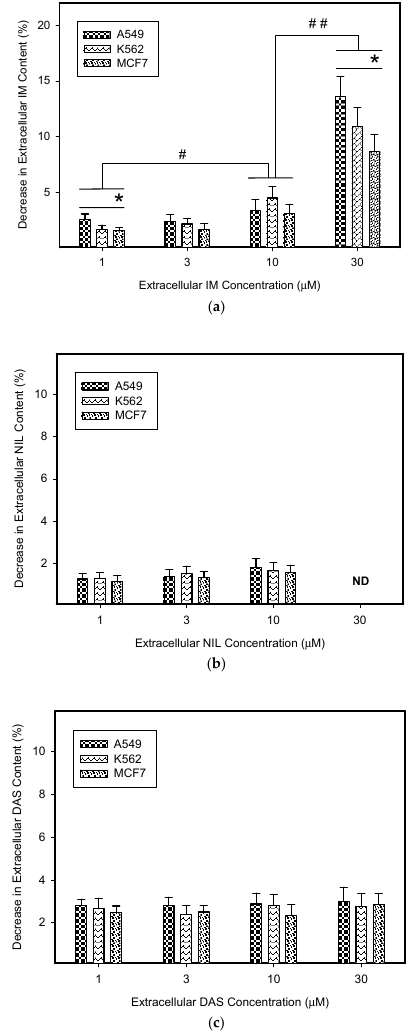
Figure8. LysosomalsequestrationofTKIsinSUN-stimulatedcellsandextracellulardrugconcentrations. ( a ) The e ff ect of the lysosomal sequestration of IM in SUN-stimulated cells on its extracellular concentration. ( b ) The e ff ect of the lysosomal sequestration of NIL in SUN-stimulated cells on